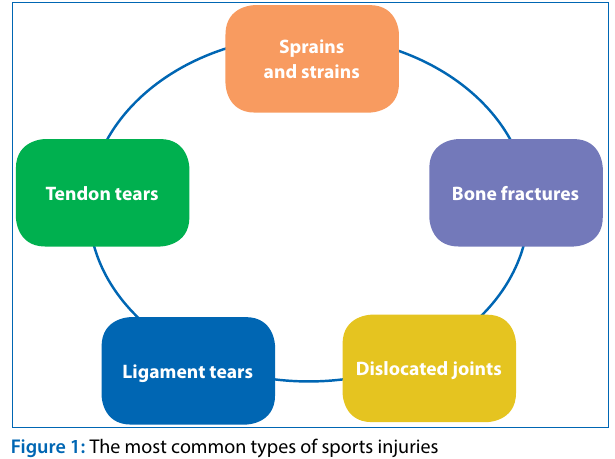
Figure 1: The most common types of sports injuries